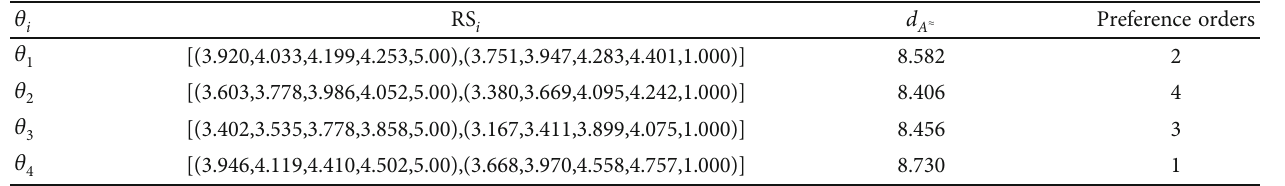
Table 5: Preference orders computed by ratio system analysis algorithm.